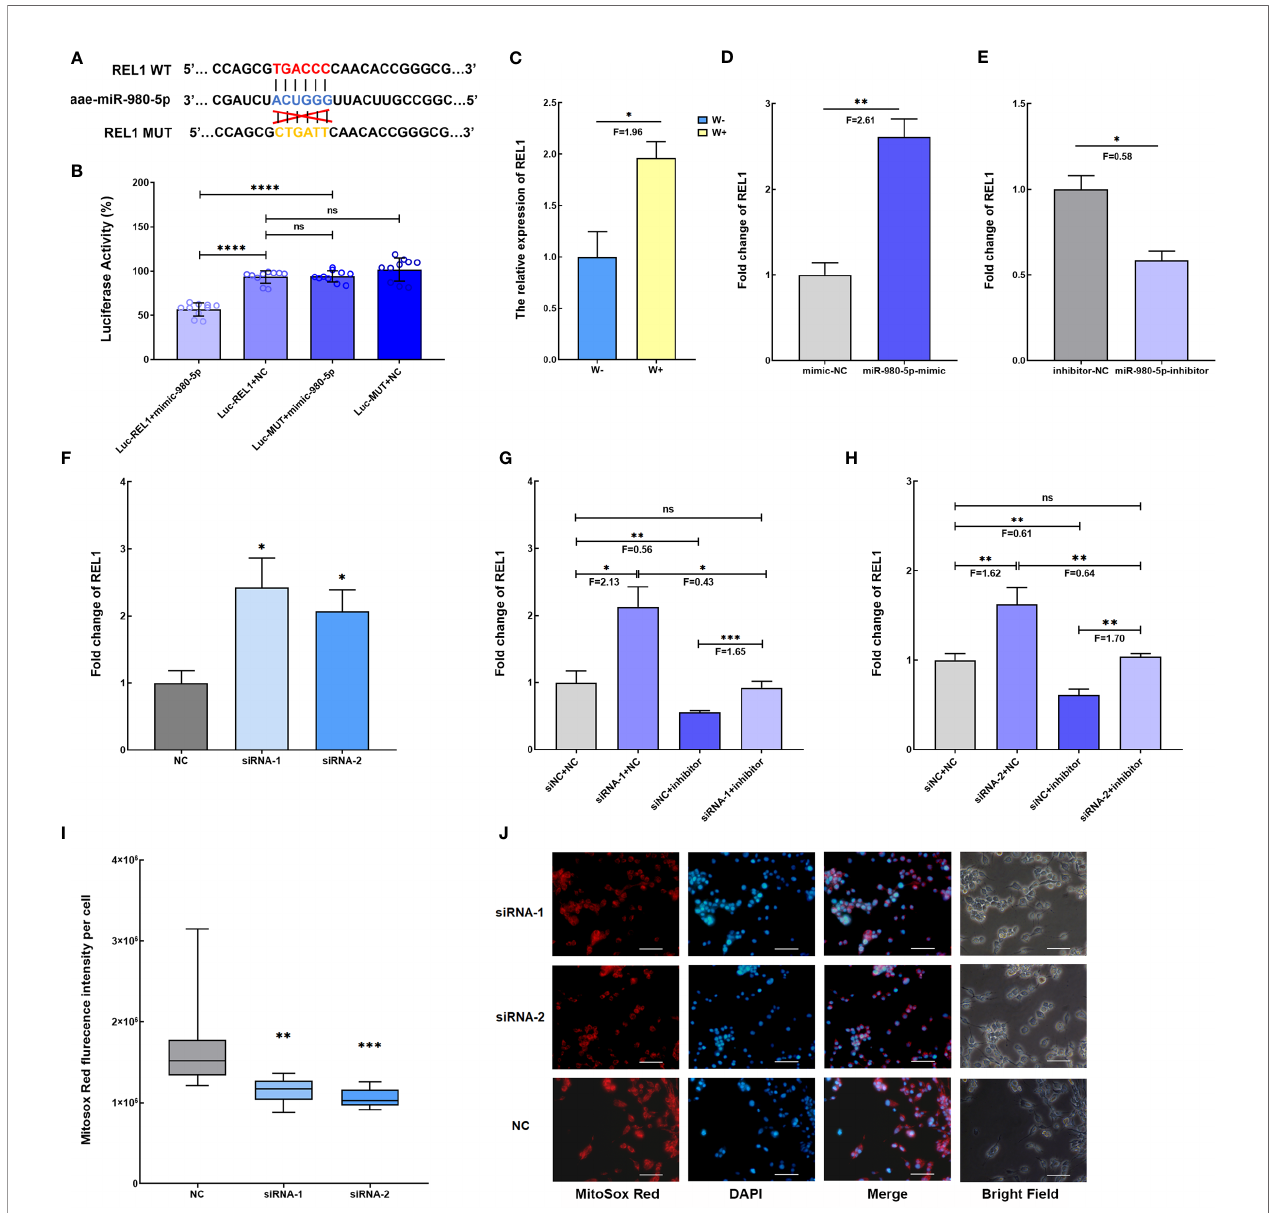
FIGURE 4 | Wolbachia -induced aae-miR-980-5p via aae-lnc-0165 increases REL1 expression, contributing to the regulation of intracellular ROS stress. (A) Schematic diagram of the predicted target binding sites between aae-miR-980-5p and REL1 by RNAhybrid. (B) Dual luciferase reporter assay con fi rms the binding sites of aae-miR-980-5p and REL1 . Luc-REL1+mimic-980-5p represents the co-transfection of psi-CHECK-2-WT-REL1 and aae-miR-980-5p mimic; Luc- REL1+NC represents the co-transfection of psi-CHECK-2-WT-REL1 and mimic control; Luc-MUT+mimic-980-5p represents the co-transfection of psi-CHECK-2- MUT-REL1 and aae-miR-980-5p mimic; Luc-MUT+NC represents co-transfection of psi-CHECK-2-MUT-REL1 and mimic control. (C) The relative expression level of REL1 in W-Aag2 (W+) and Aag2 (W-) cells. (D) The gain-of-function assay shows that increasing aae-miR-980-5p induces the expression of REL1 at 48 h post- transfection. (E) The loss-of-function assay indicates that silencing of aae-miR-980-5p reduces the expression of REL1 at 48 h post-transfection. (F) The fold change of REL1 expression at 120 h post transfection with siRNA for aae-lnc-0165. Validation of the regulatory relationship for aae-lnc-0165, aae-miR-980-5p, and REL1 via rescue assay using two sequence speci fi c siRNA-1 (G) and siRNA-2 (H) for aae-lnc-0165. siNC+NC represents the cell group treated with siRNA control and inhibitor control; siRNA-1/-2+inhibitor represents the cell group treated with siRNA-1/-2 for aae-lnc-0165 and aae-miR-980-5p inhibitor; siNC + inhibitor represents the cell group treated with siRNA control and aae-miR-980-5p inhibitor; siRNA-1/-2 +NC represents the cell group treated with siRNA-1/-2 and inhibitor control. (I) The fl uorescence intensity of mitochondrial ROS per cell at 72 h post transfection using the Mitosox Red probe. The bar represents the range of maximum and minimum value, and the horizontal shows the median. NC represents Aag2 cells transfected with siRNA control. siRNA-1 and siRNA-2 indicates the aae-lnc-0165- depleted W-Aag2 cells by transfection of two distinct siRNAs for aae-lnc-0165. (H) The representative image of siRNA-transfected Aag2 cells at ×40 magni fi cation. The mitochondrial ROS and nucleus were stained with the Mitosox Red probe (red) and DAPI (blue). The white line indicates 50 micrometers; **** P < 0.0001; *** P < 0.001; ** P < 0.01; * P < 0.05; ns means no signi fi cant difference. F means fold